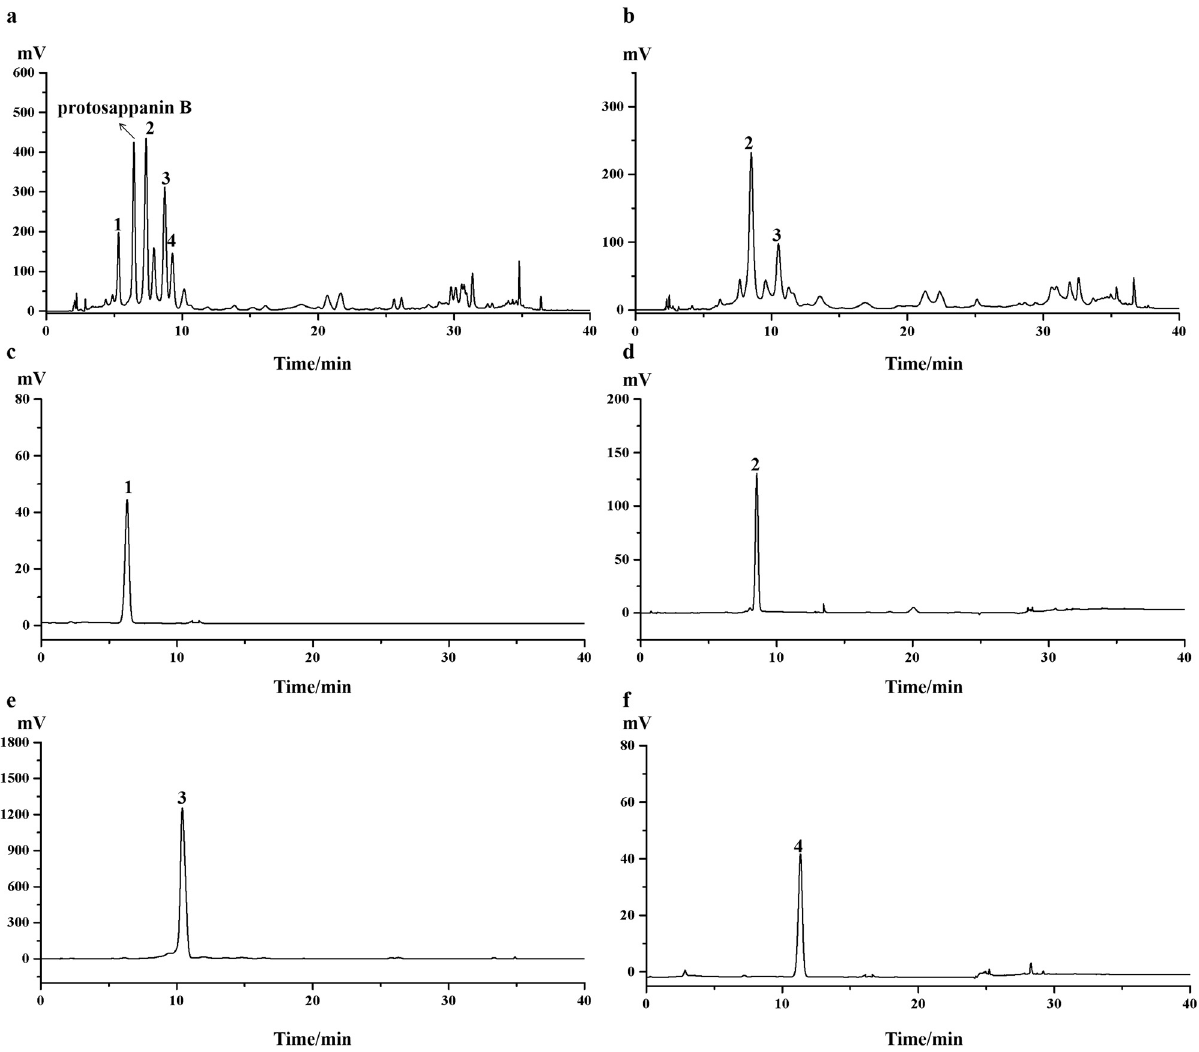
Figure 4: HPLC analysis of C . sappan L. HPLC conditions are presented in Section 2.6. Peak 1 is episappanol, peak 2 is brazilin, peak 3 is sappanol, and peak 4 is sappanol 4 - O - methylsappanol. ( a ) Ethyl acetate extract sample of C . sappan L.; ( b ) enriched sample of HSCCC ( the same below ) ; ( c ) episappanol separated from SGCC ( the same below ) combined with prep - HPLC ( the same below ) ; ( d ) brazilin separated from SGCC combined with prep - HPLC; ( e ) sappanol separated from HSCCC combined with prep - HPLC; and ( f ) 4 - O - methylsappanol sepa - rated from SGCC combined with prep -